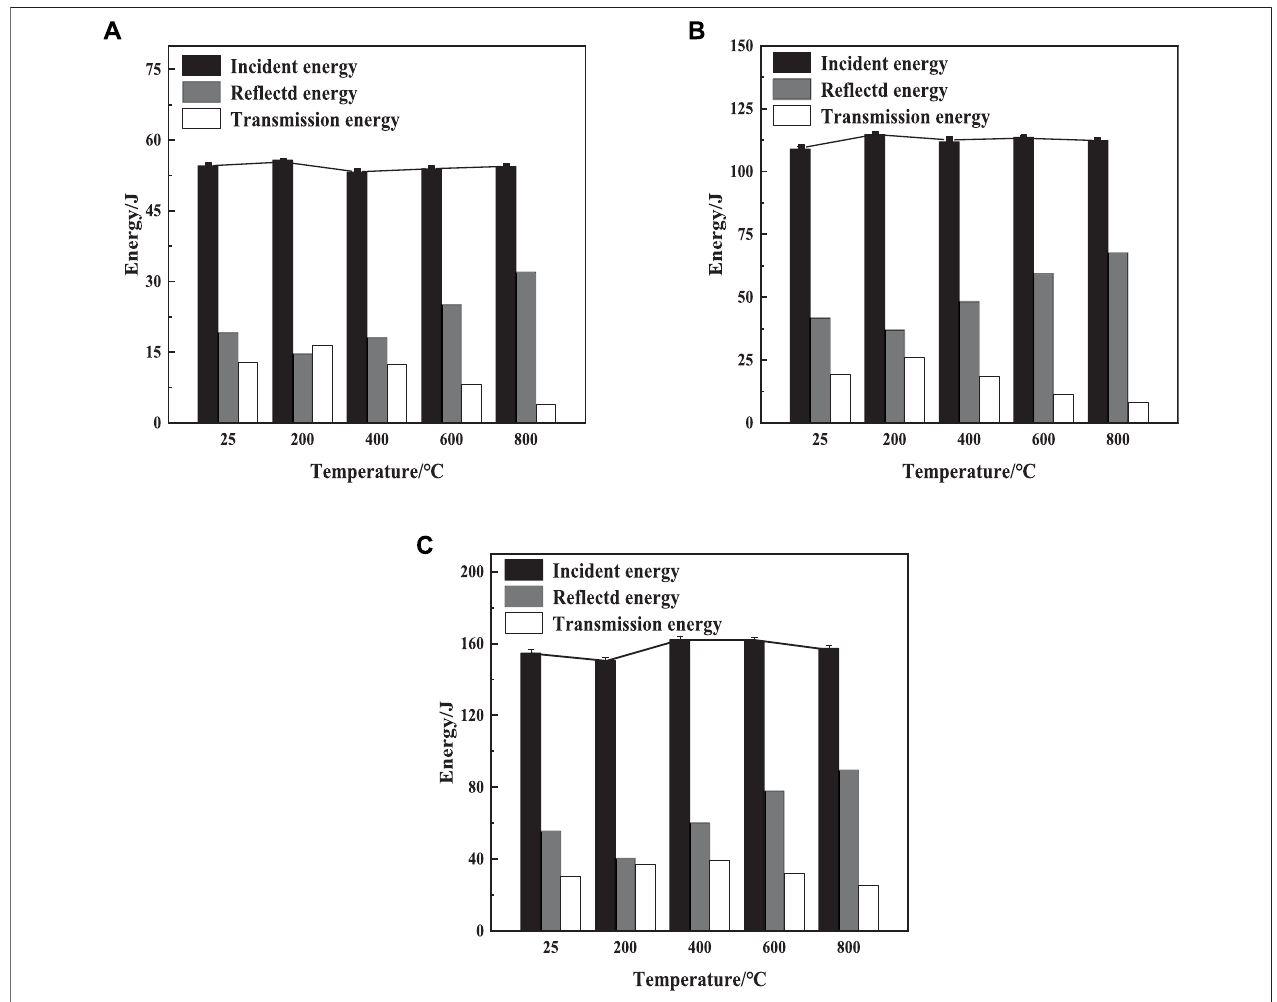
FIGURE 5 | Relationship curves of re fl ected and transmitted energies with incident energy at impact velocities of (A) 8.5 m/s, (B) 11.5 m/s, and (C) 13.5 m/s.